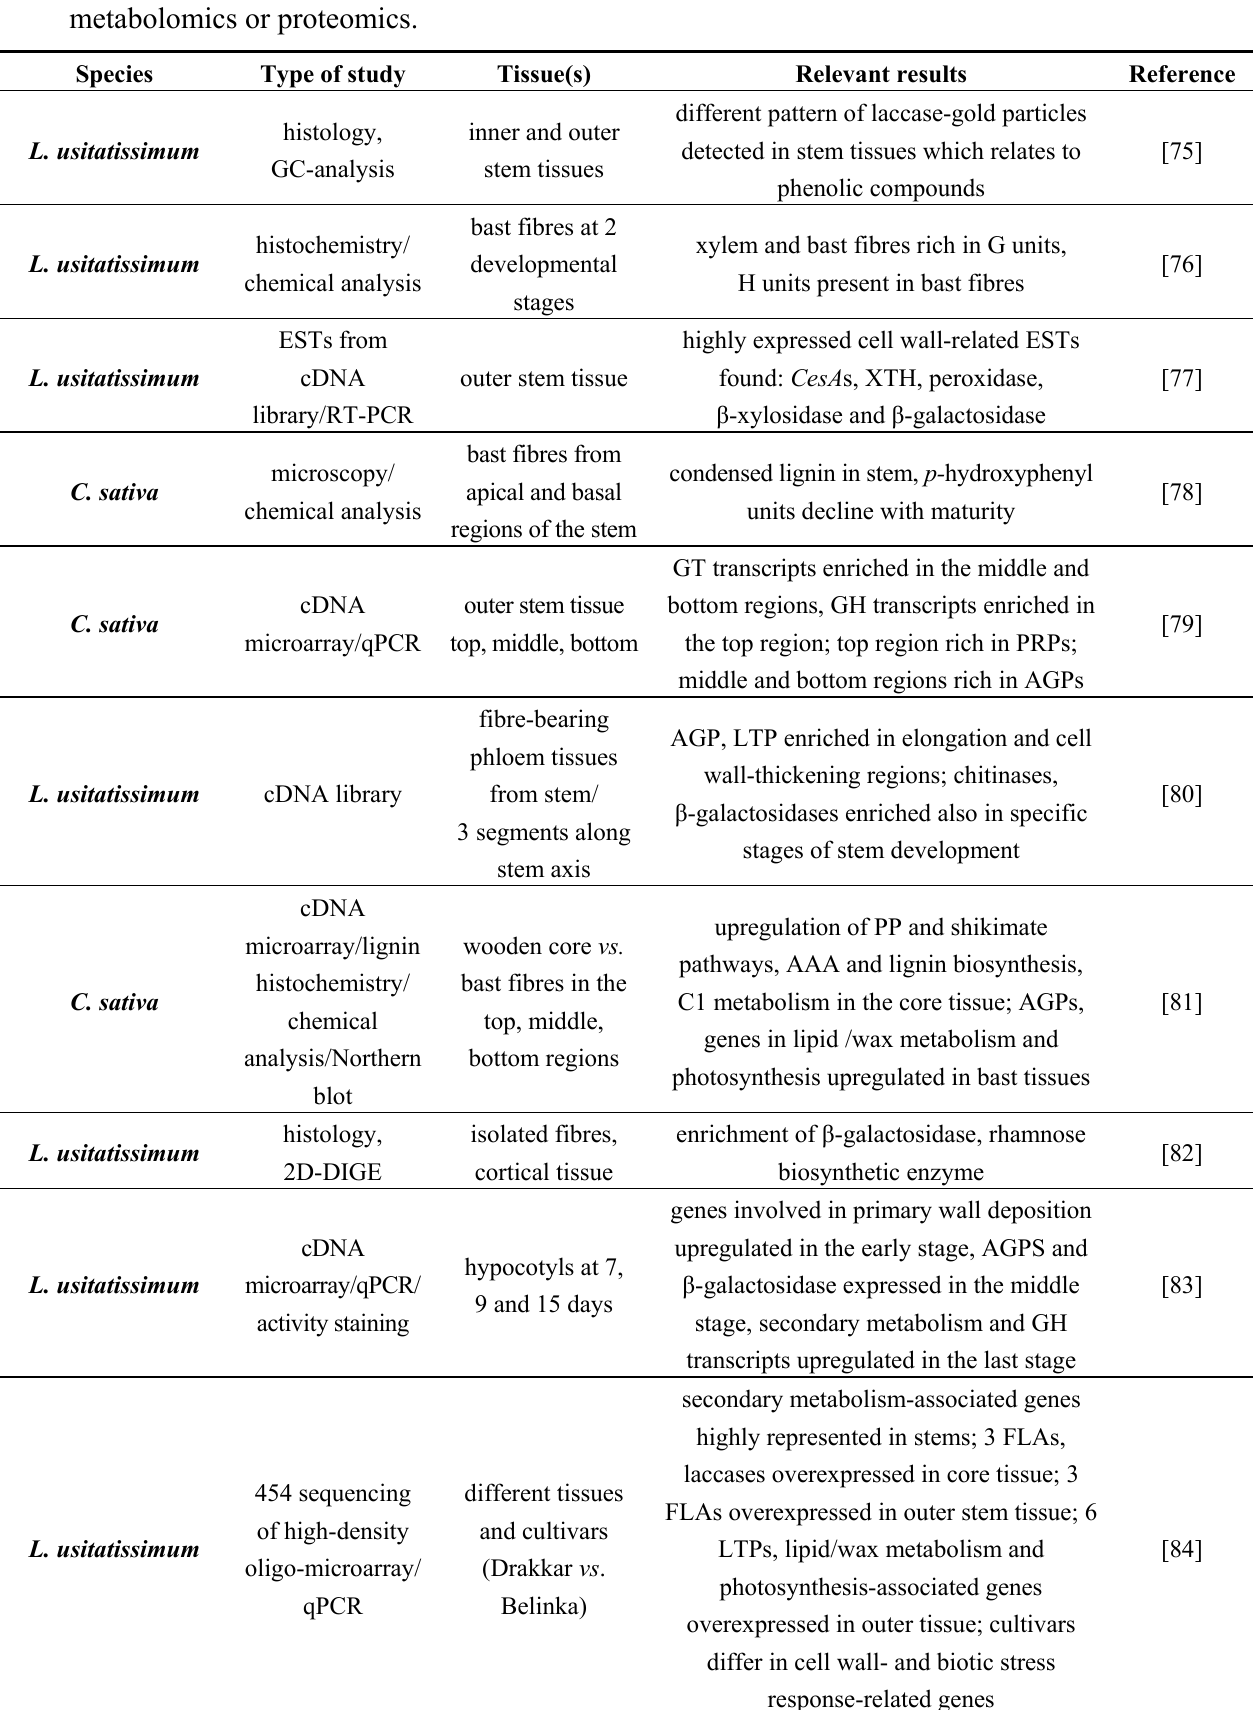
Table 1. Summary of the available studies on fibre crops addressing transcriptomics, metabolomics or